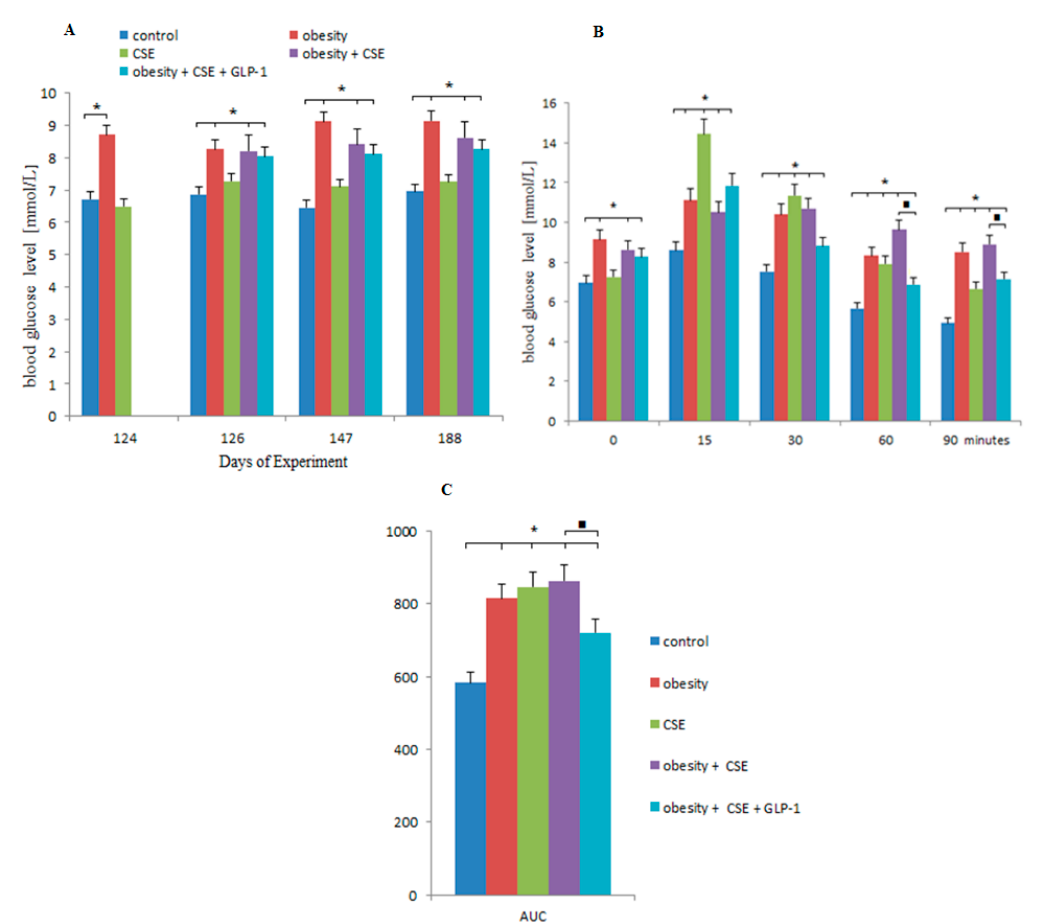
Figure 2. The glucose level in the blood of female C57BL/6 mice in the development of obesity and emphysema ( A ). Oral glucose tolerance test ( B ) and area under the curve (AUC) ( C ) on the 186th day of the experiment. * - significance of difference compared with control group ( p < 0.05); ■ - significance of difference compared with the obesity + CSE group ( p < 0.05).